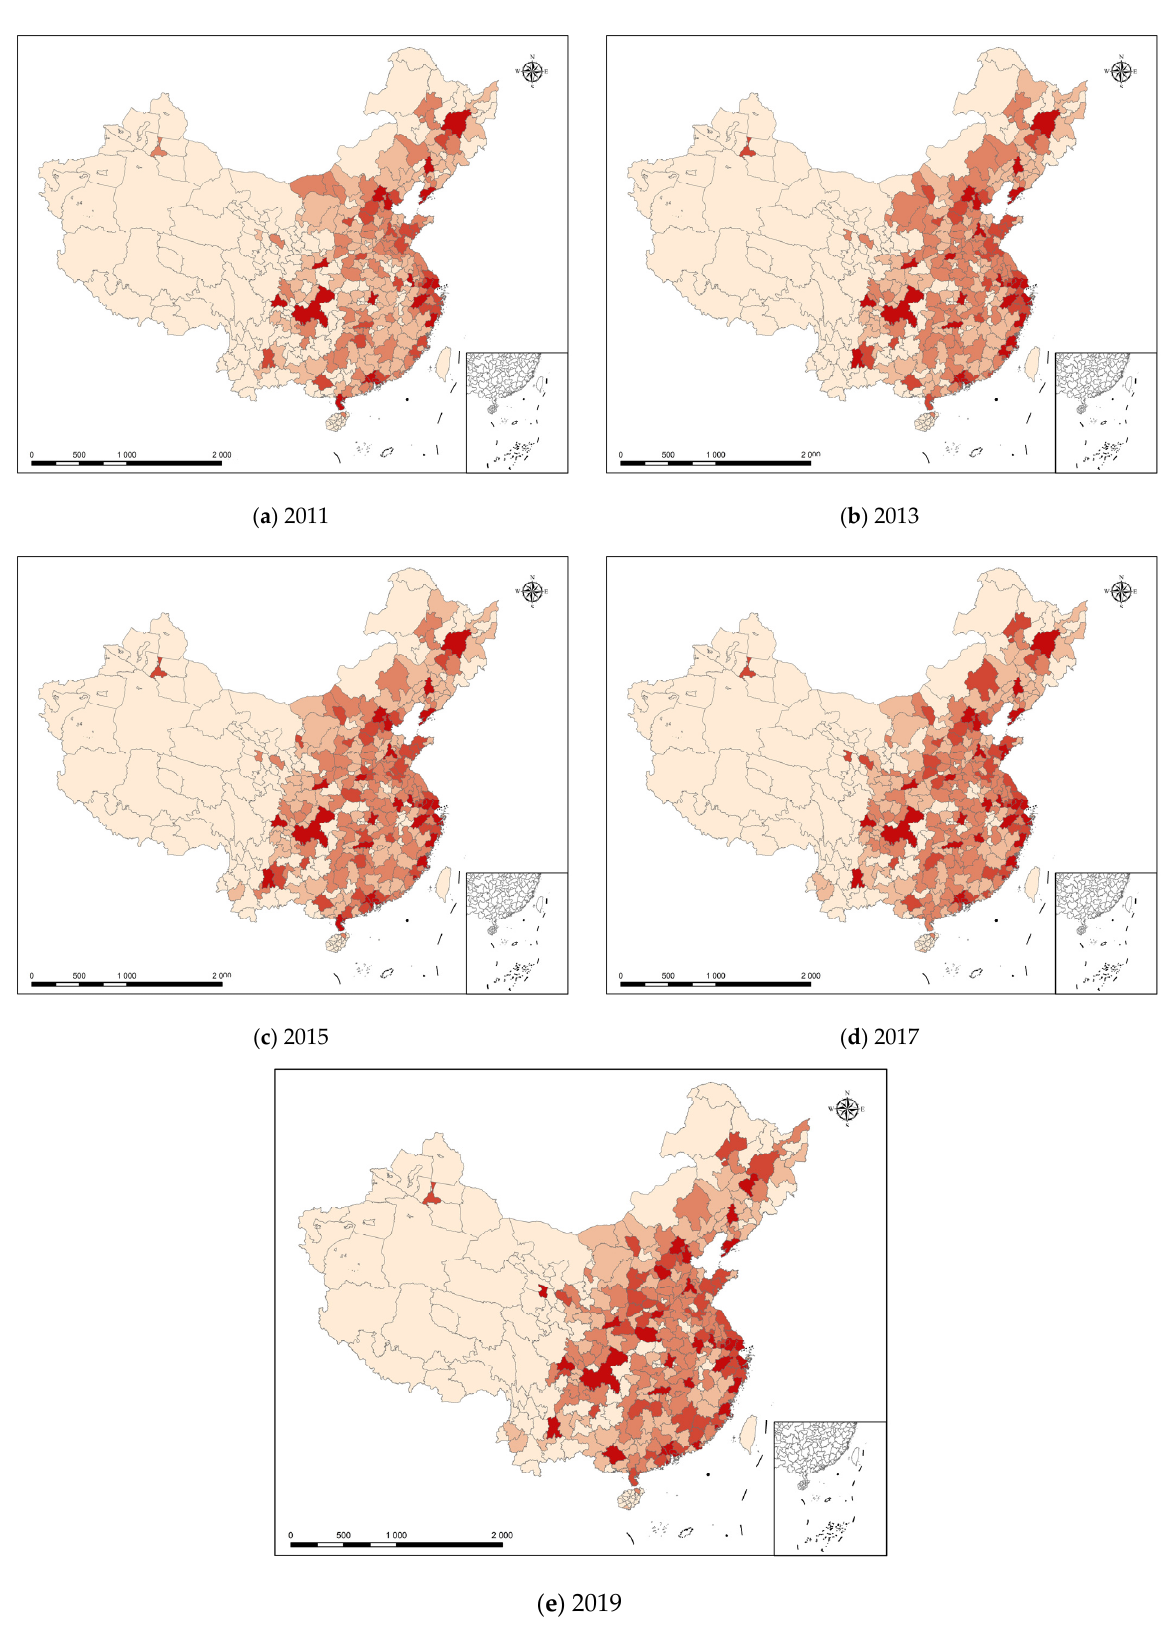
Figure 2. Spatial Distribution of the Principal Components of National Digital Economy